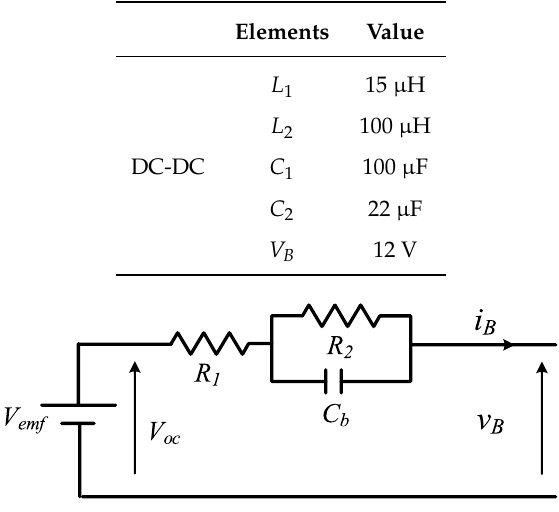
Table 2. Parameters of the buck/buck-boost converter.